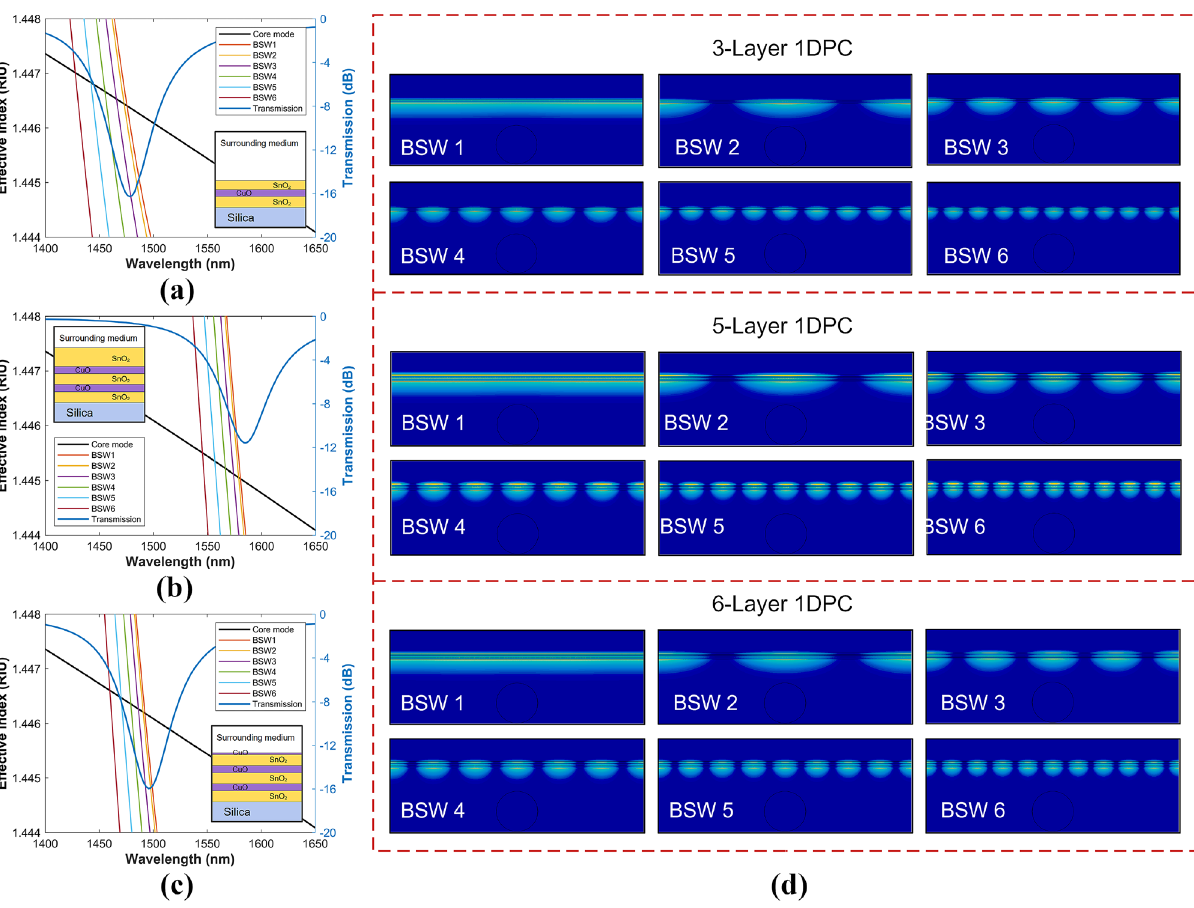
Figure 2. Dispersion curves of the core-guide mode and the BSW modes for the ( a ) 3-Layer, ( b ) 5-Layer, and ( c ) 6-Layer 1DPC. The blue lines (right axis) represent the calculated transmission spectra, and the figure insets are the 1DPC analyzed. ( d ) Optical field intensity distributions of the supported BSW modes for the analyzed 1DPCs. For the sake of simplicity, only the dispersion curves of the first 6 BSW modes are